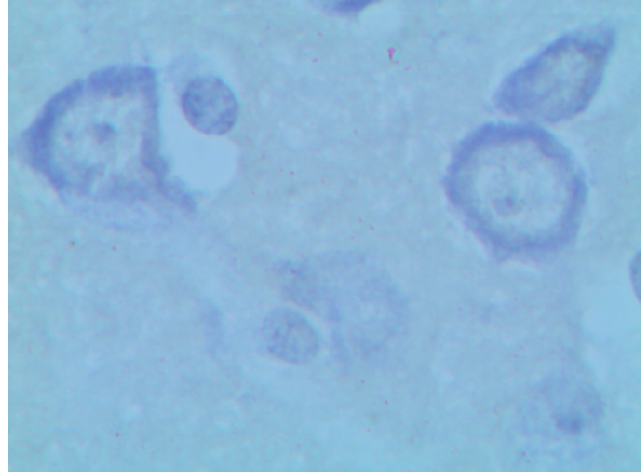
Figure 12. The brain of a rat exposed to subchronic intoxication with copper oxide nanoparticles against the background of bioprotective complex administration, the nucleus caudatus area (Nissl stain, magnification ×900). The tigroid’s distribution is similar to that in control rats (compare with Figure 10).